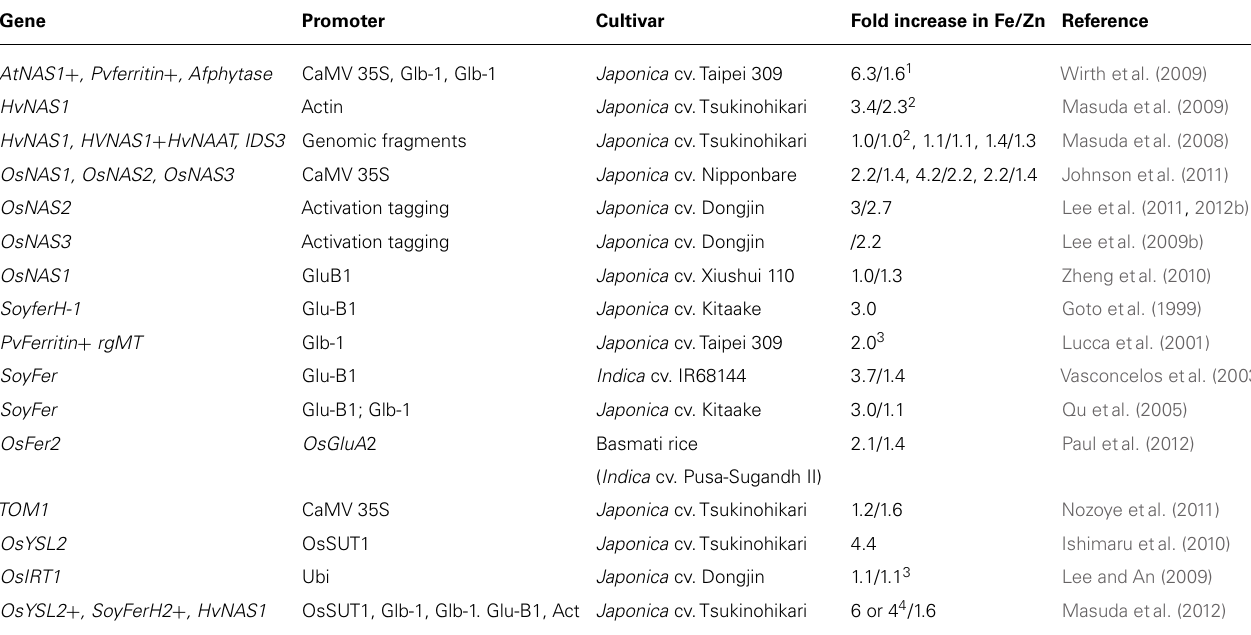
Table 1 | Summary of different approached undertaken for mineral biofortification of rice.